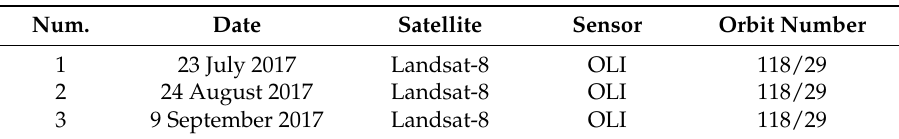
Table 2. Basic information of the auxiliary